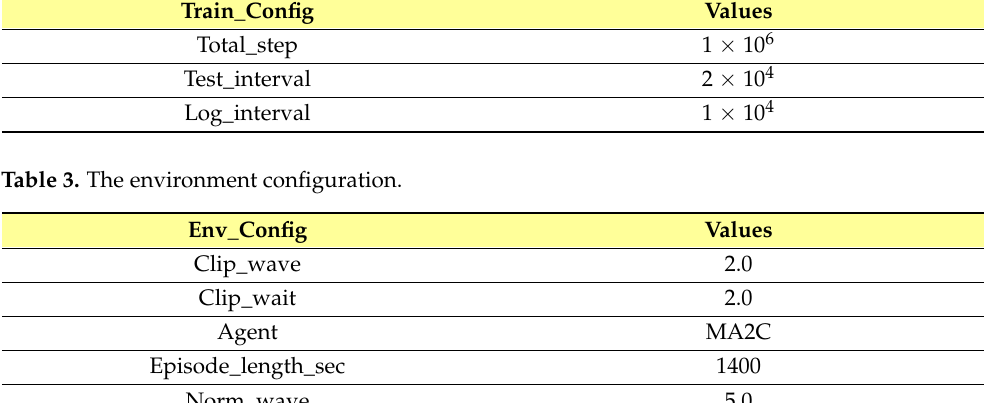
Table 2. The train configuration.